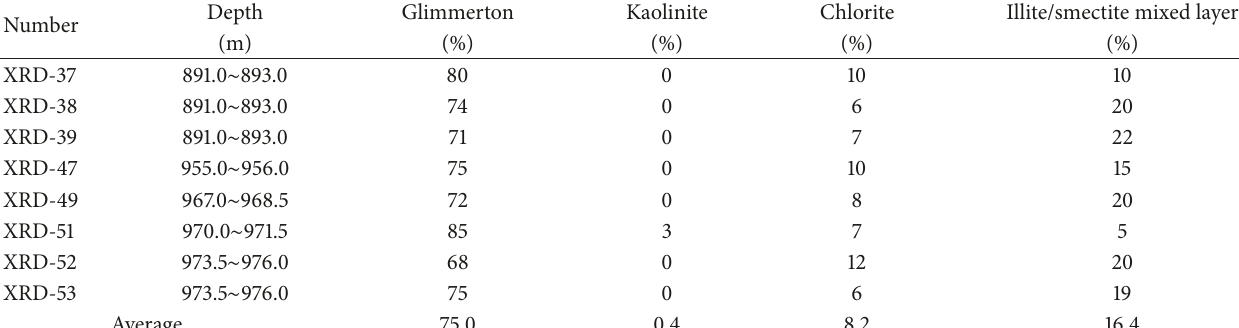
Table 5: XRD analysis results of clay minerals in interlayers of Well M1#.